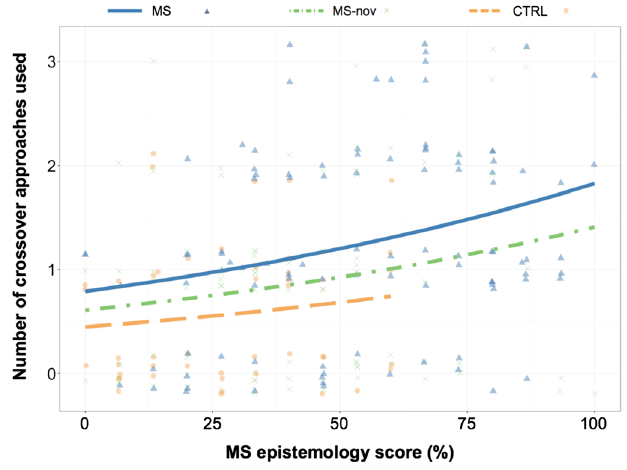
FIG. 6. Average MS epistemology score (% of favorable responses) for each instructional group. Error bars represent (cid:2) 1 standard error of the mean.